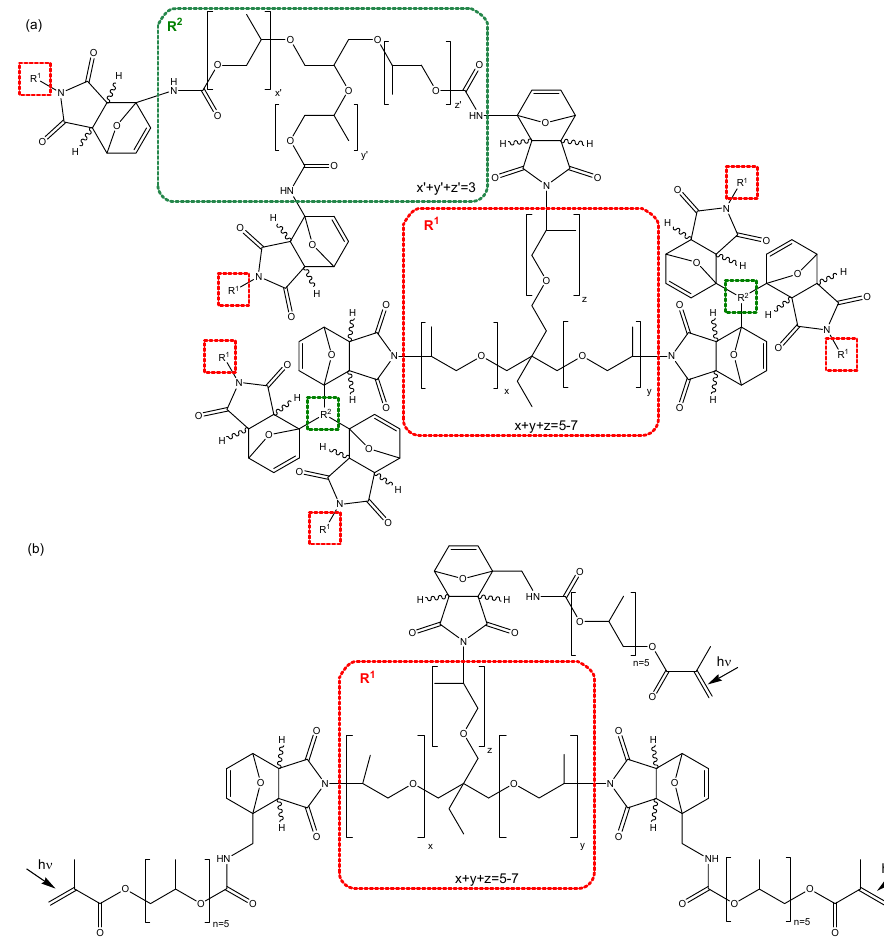
Figure 3. Chemical structures of the polymer networks ( a ) 3M ‐ 3F630 and ( b ) 3M ‐ F375PMA.